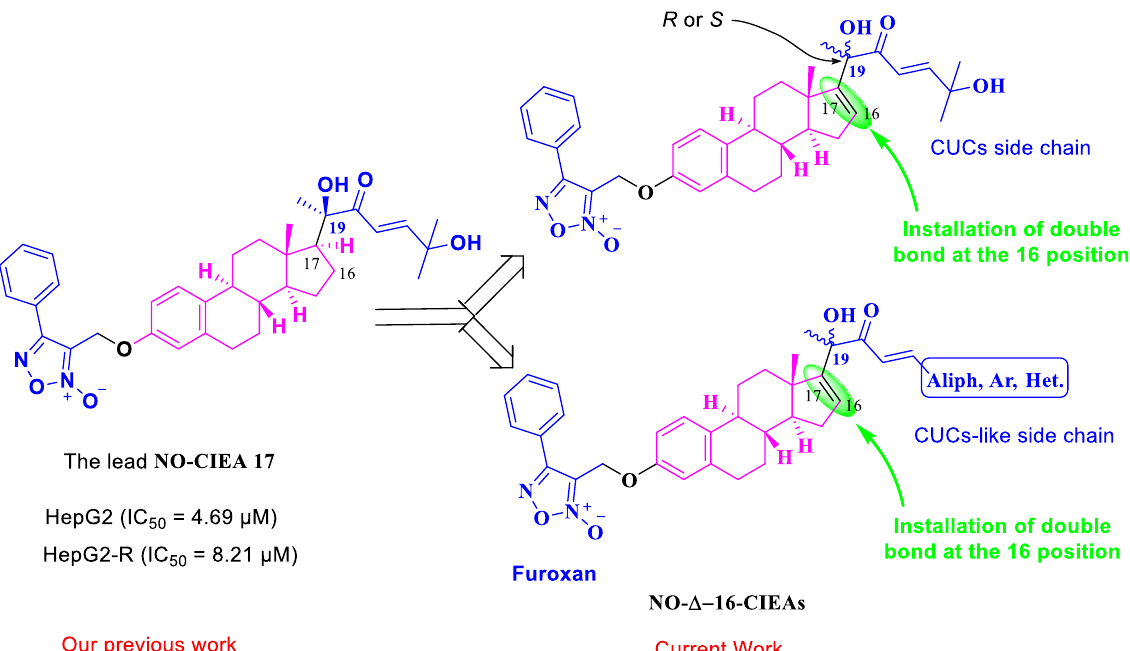
Figure 1. Design strategy for target compounds NO- ∆ -16-CIEAs.